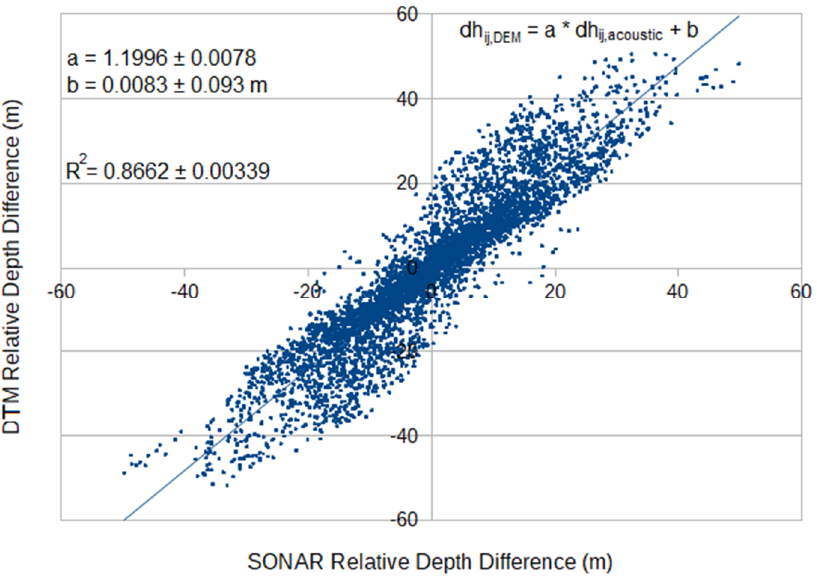
Figure 22. Relative depth differences compared between DTM- and acoustic-data-derived